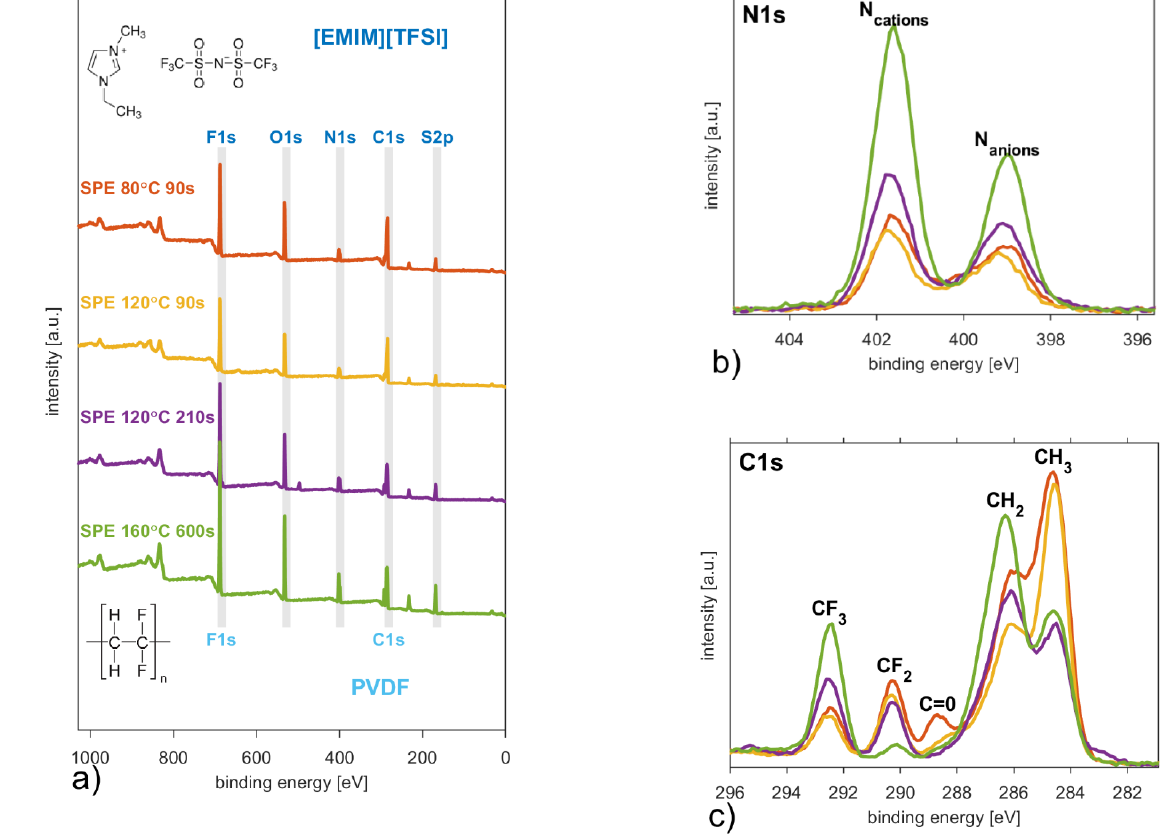
Figure 6. ( a ) survey XP spectrum, ( b ) N1s XP spectrum and ( c ) C1s XP spectrum of the solid polymer electrolytes prepared in four treatment conditions.